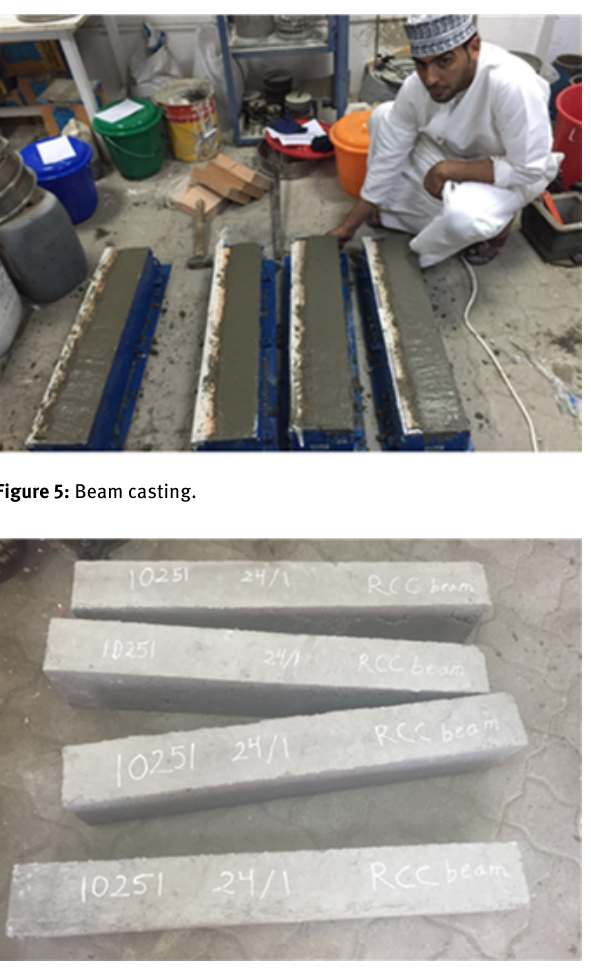
Figure 6: Beams after curing.